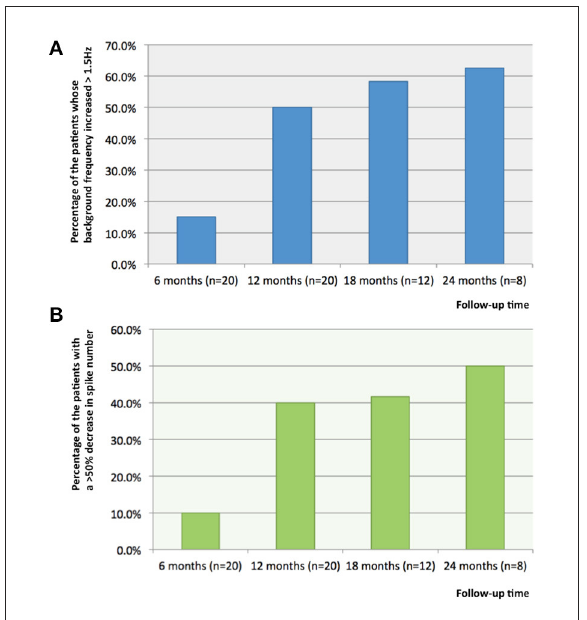
FIGURE2 The percentages of the patients with increased background frequency and decreased number of spikes on interictal EEG. (A) Compared with the baseline data of patients before stimulator implantation, at 6, 12, 18, and 24 months after stimulator implantation, the percentage of the patients whose background frequency increased > 1.5Hz was respectively, 15.0, 50.0, 58.3 and 62.5%; and (B) Compared with the baseline data, at 6, 12, 18, and 24 months after stimulator implantation, the percentage of the patients whose interictal EEG showed a > 50% decrease in spike number was respectively, 10, 40.0, 41.6 and